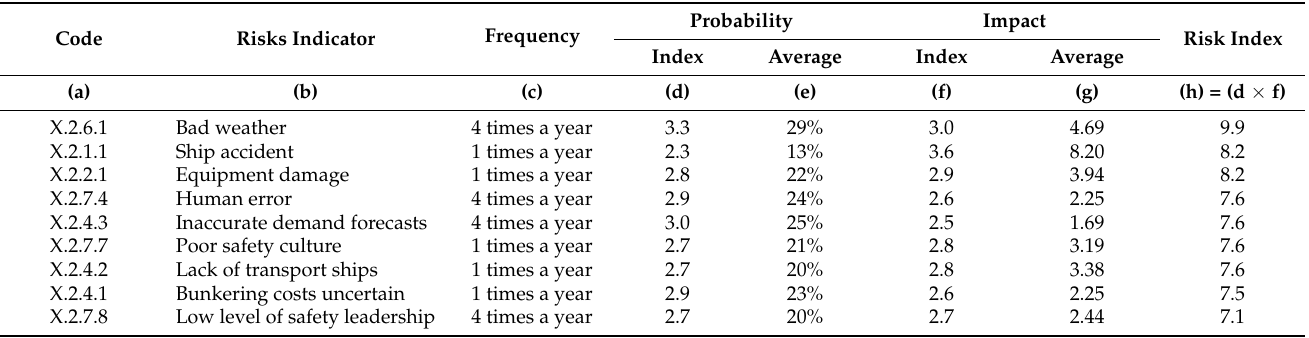
Table 5. The highest order of the SS-LNG supply chain risk